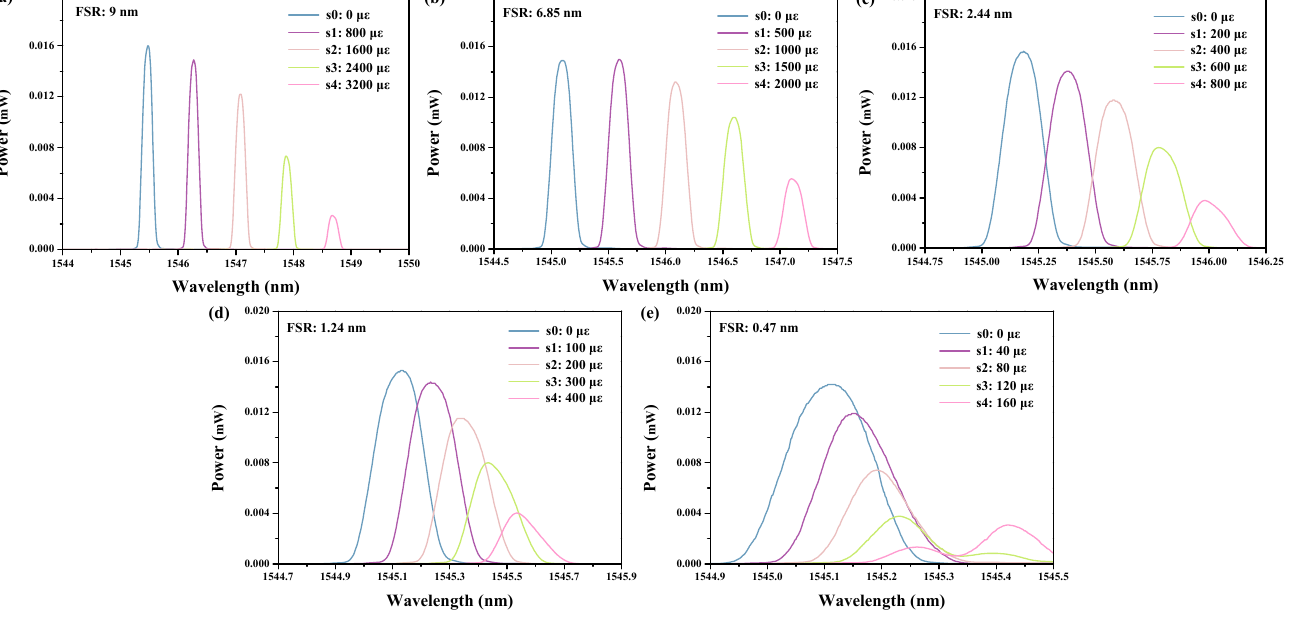
Figure 3. From ( a – e ), FBG is subjected to strain variation spectra with FSR of 9 nm, 6.85 nm, 2.44 nm, 1.24 nm, and 0.47 nm for the TDI, where the strain size is set according to the magnitude of the FSR. In Figure 3a, the FSR is set to 9 nm, which has a high operating range, and a strain of 800 µε is applied at each step of the wavelength, resulting in a variation of the output